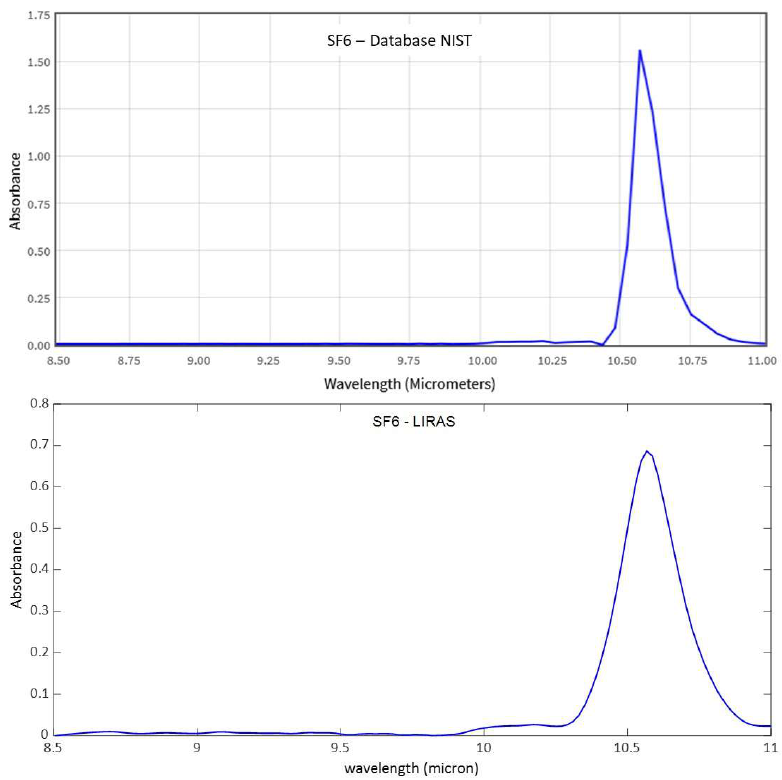
Figure 11. Comparison between a reference spectrum of sulfur hexafluoride from the NIST database (at 4 cm –1 resolution) and spectrum acquired by the LIRAS sensor for SF6 at 100 ppm.